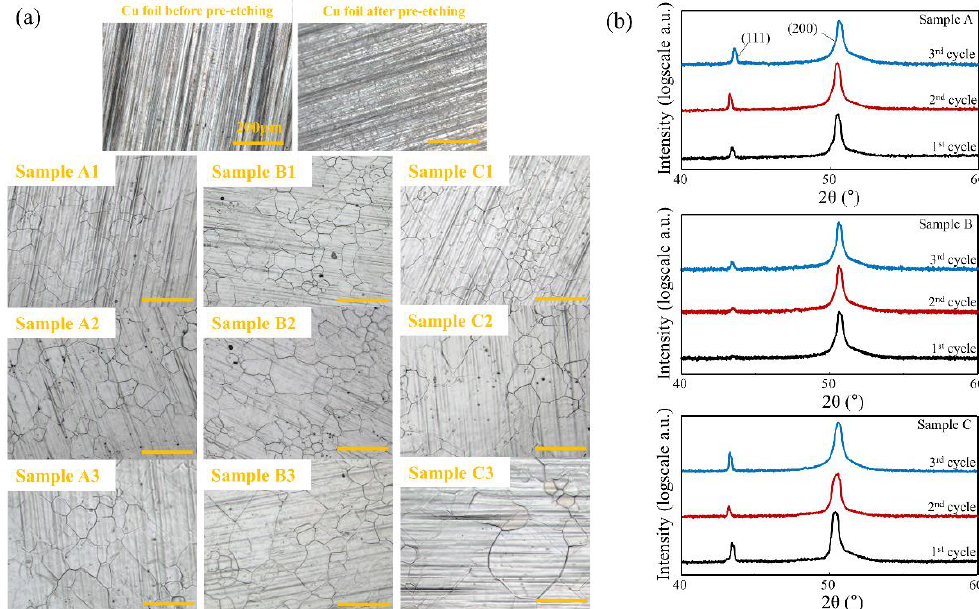
Figure 2. ( a ) Light microscopy (LM) images of Samples A–C, after each CVD cycle. The red shape on each LM image is the shape of the grain ( b ) X-ray diffraction (XRD) intensity ratios I n / I 1 ( n is the number of CVD cycle) for the (111) peak, for Samples A–C.